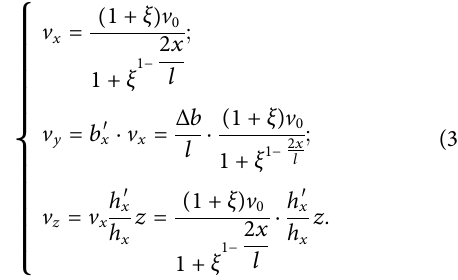
According to the roller surface equation dS (cid:1)